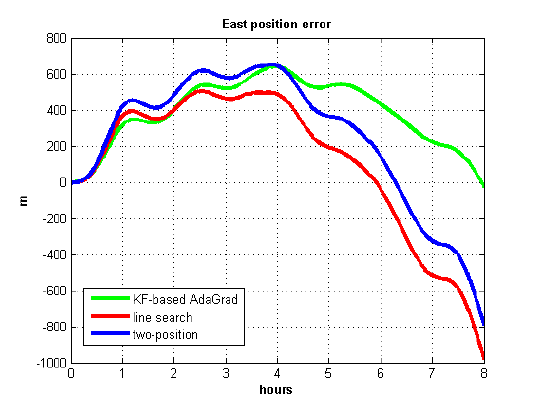
Figure 12. North velocity error.